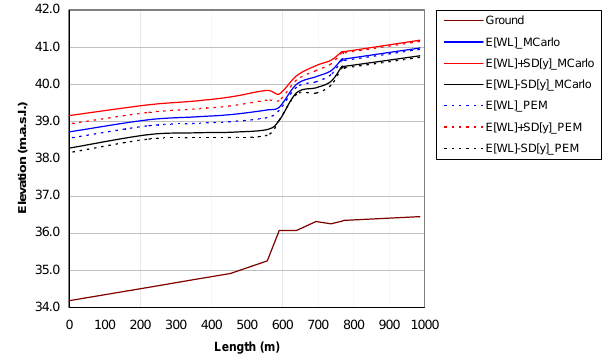
Fig. 11. 1-D HEC-RAS model. Comparison of water profiles for case flow 500m 3 s − 1 . Mean and standard deviation values esti- mated with Monte Carlo and point-estimate